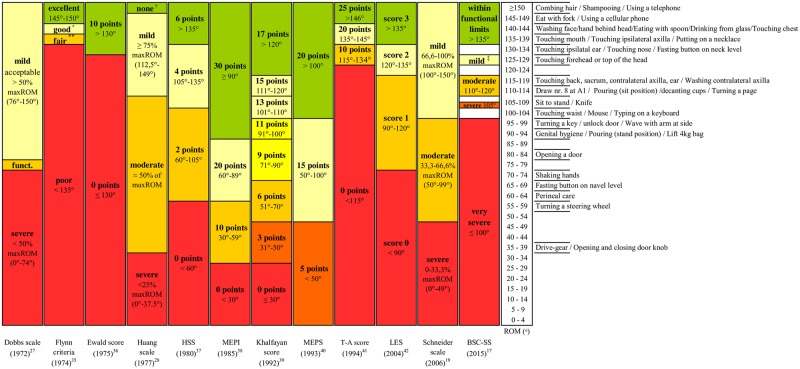
Schematic illustration of elbow flexion rating scales and their cut-off points per degrees of Range of Motion (ROM) as well as required elbow flexion ROM for activities of daily life (ADL) as synthesized by Oosterwijk et al. [29–30].HSS: Hospital for special surgery scoring; MEPI: Mayo elbow performance index; MEPS: Mayo elbow performance score; T-A score: Timmerman-Andrew elbow score; LES: Liverpool elbow score; BSC-SS: Burn scar contracture severity scale; accept.: acceptable; funct.: functional = about 50% max ROM; *: good = 140°- 144°, ** fair = 135°- 139°, †: none = no limitation of motion, ‡: mild = 125°-130°.